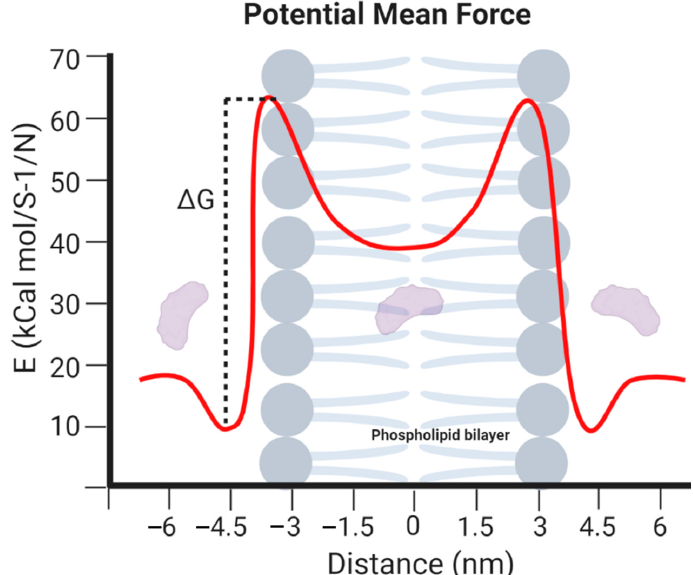
Figure 6. Potential mean force curve calculated from an umbrella sampling simulation across a phospholipid bilayer model where the zero represents the center of mass (COM) of a 6 nm thick membrane (Created with